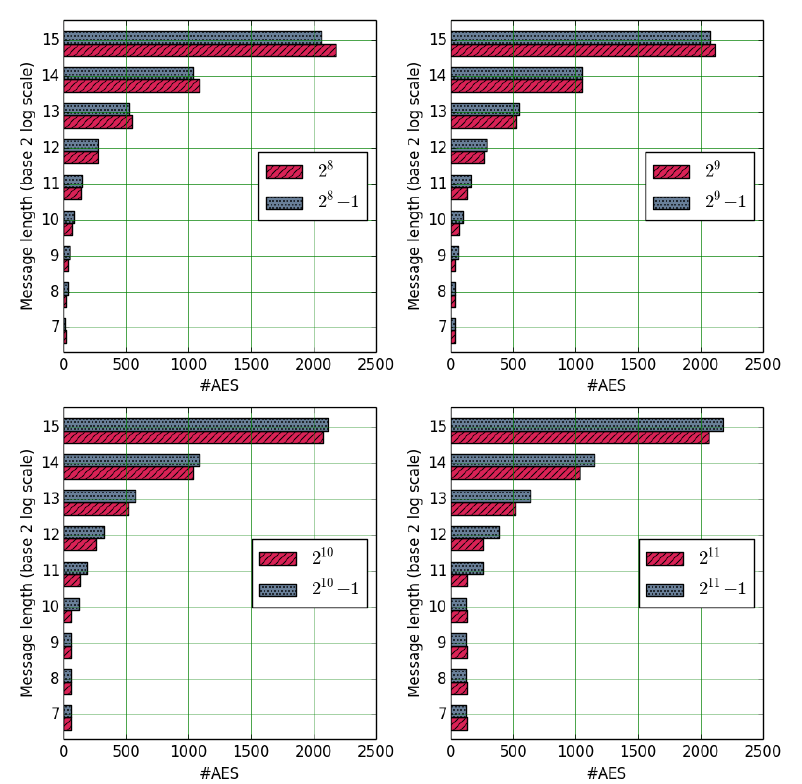
Figure 13: Number of AES operations needed to IM -encrypt a message as a function of the message length, with the choice of AES - GCM as internal nonce-based AE scheme. Plots are given for 8 different chunk lengths: 2 8 − 1, 2 8 , 2 9 − 1, 2 9 , 2 10 − 1, 2 10 , 2 11 − 1 and 2 11